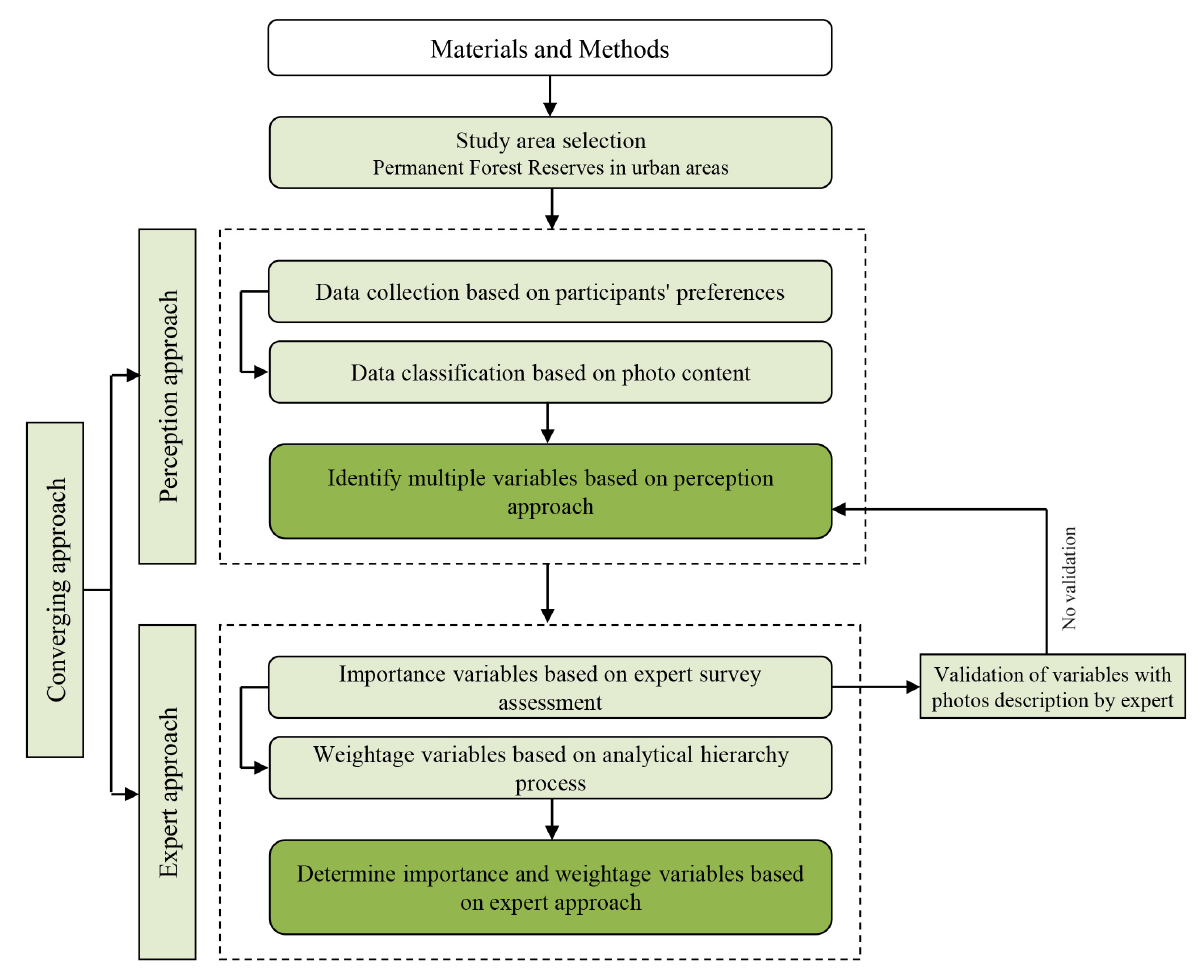
Figure 1. Methodological framework for the study.